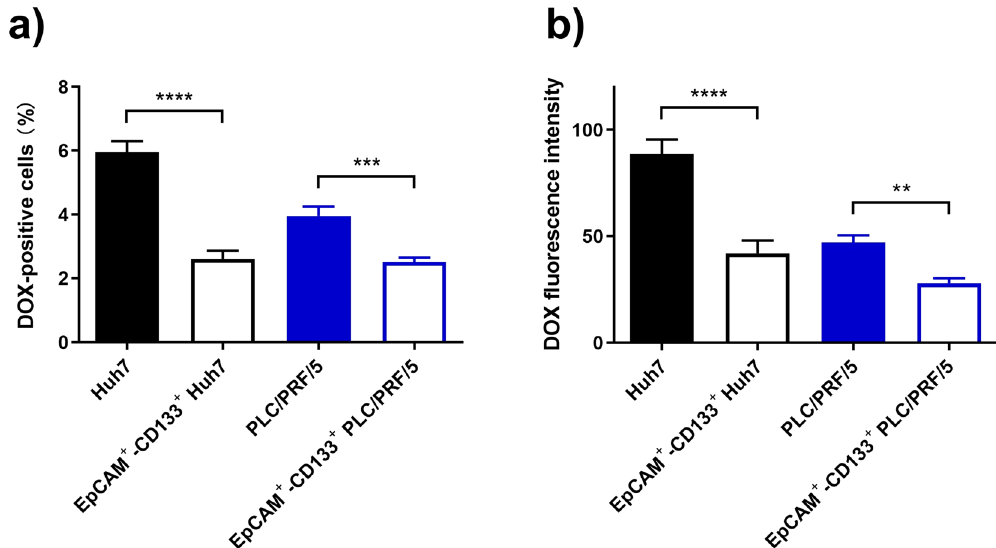
Figure 2. Robust extrusion of doxorubicin (DOX) by EpCAM + –CD133 + population of Huh7 and PLC/PRF/5 cells. The Huh7 or PLC/PRF/5 cells were treated with 200 nM or 100 nM of DOX for 24 h, respectively. The percentage of DOX fluorescence-positive cells ( a ), as well as the intracellular DOX fluorescence expressed as the median fluorescence intensity ( b ) in the bulk and the EpCAM + –CD133 + population of Huh7 and PLC/PRF/5 cells, were determined using flow cytometry. Data shown are means ± SD, (n = 3). **** p < 0.0001; *** p < 0.001; ** p < 0.01; compared with the bulk population of Huh7 and PLC/PRF/5 cells